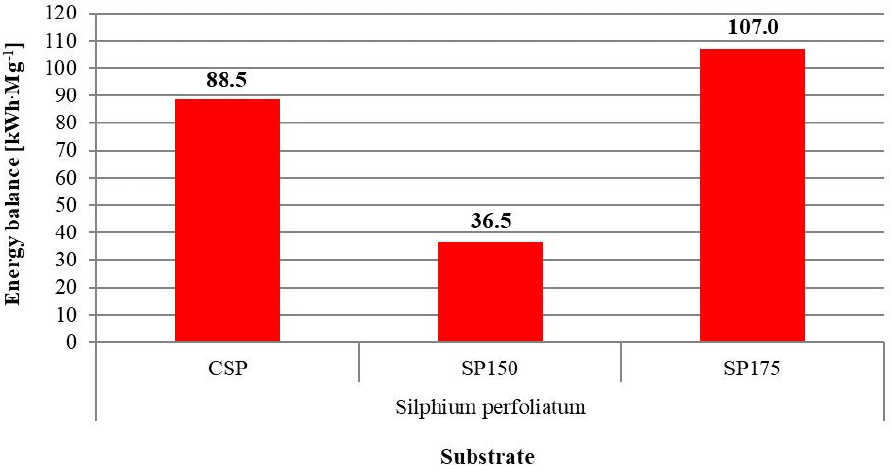
Figure 7. A comparison of the energy balances of the substrates comminuted with the MB11C impact mill and extruded with the E-1000 extruder.